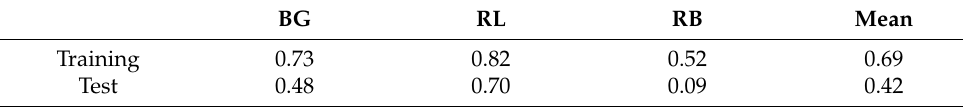
Table 19. IoU scores for Rice blast in Experiment D.